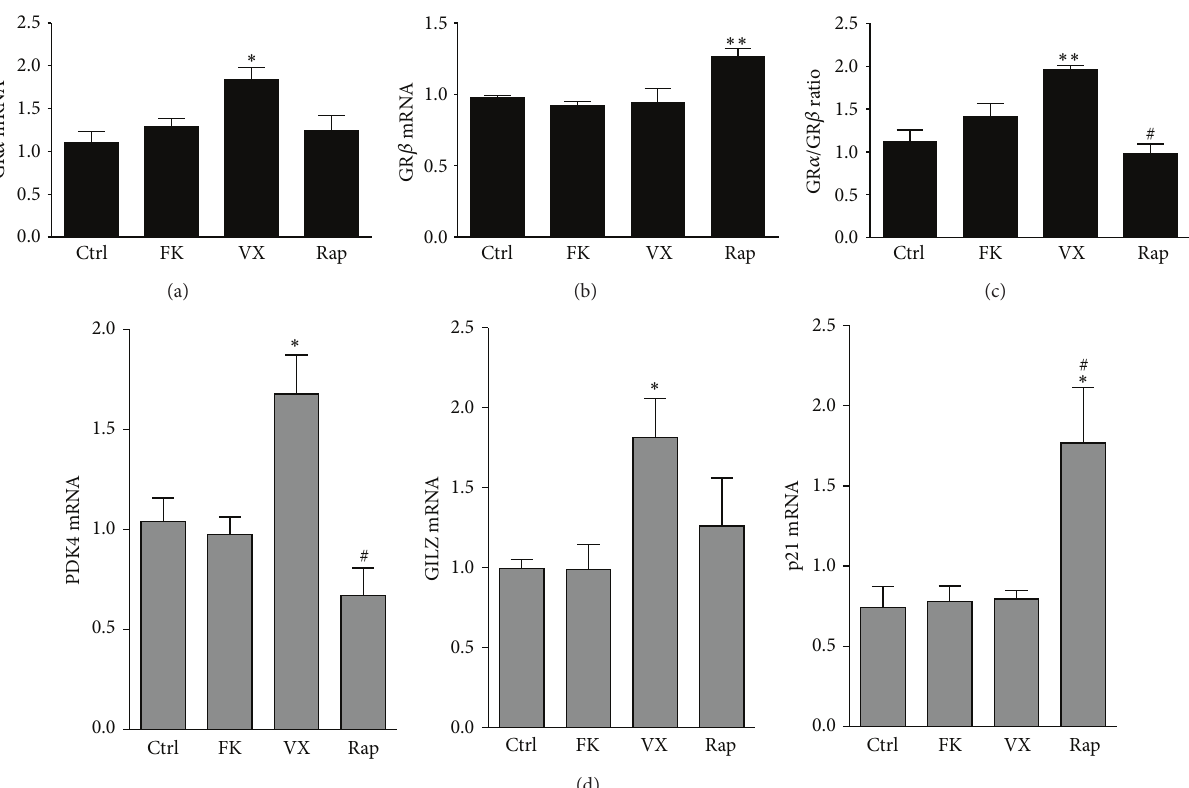
Figure 3: Timcodar increases glucocorticoid responsiveness by increasing the GR 𝛼 to GR 𝛽 ratio. Measurement of GR 𝛼 and GR 𝛽 mRNA was performed by real-time PCR analysis of differentiated 3T3-L1 adipocytes treated with vehicle (Ctrl), 1 𝜇 M FK506 (FK), 1 𝜇 M timcodar (VX), and 1 𝜇 M rapamycin (Rap). (a) GR 𝛼 , (b) GR 𝛽 , and (c) the ratio of GR 𝛼 /GR 𝛽 . ∗ 𝑝 < 0.05 ; ∗∗ 𝑝 < 0.01 (versus control); # 𝑝 < 0.05 (timcodar versus rapamycin treatment) ( ± S.E.; 𝑛 = 3 ). (d) mRNA of glucocorticoid responsive genes PDK4, GILZ, and p21. ∗ 𝑝 < 0.05 (versus control); # 𝑝 < 0.05 (timcodar versus rapamycin treatment) ( ± S.E.; 𝑛 = 3